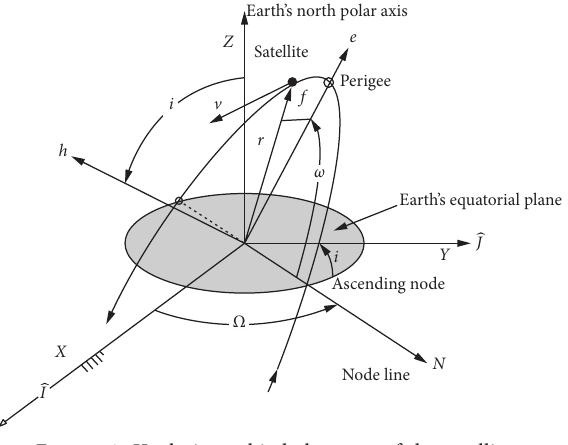
Figure 2: Keplerian orbital elements of the